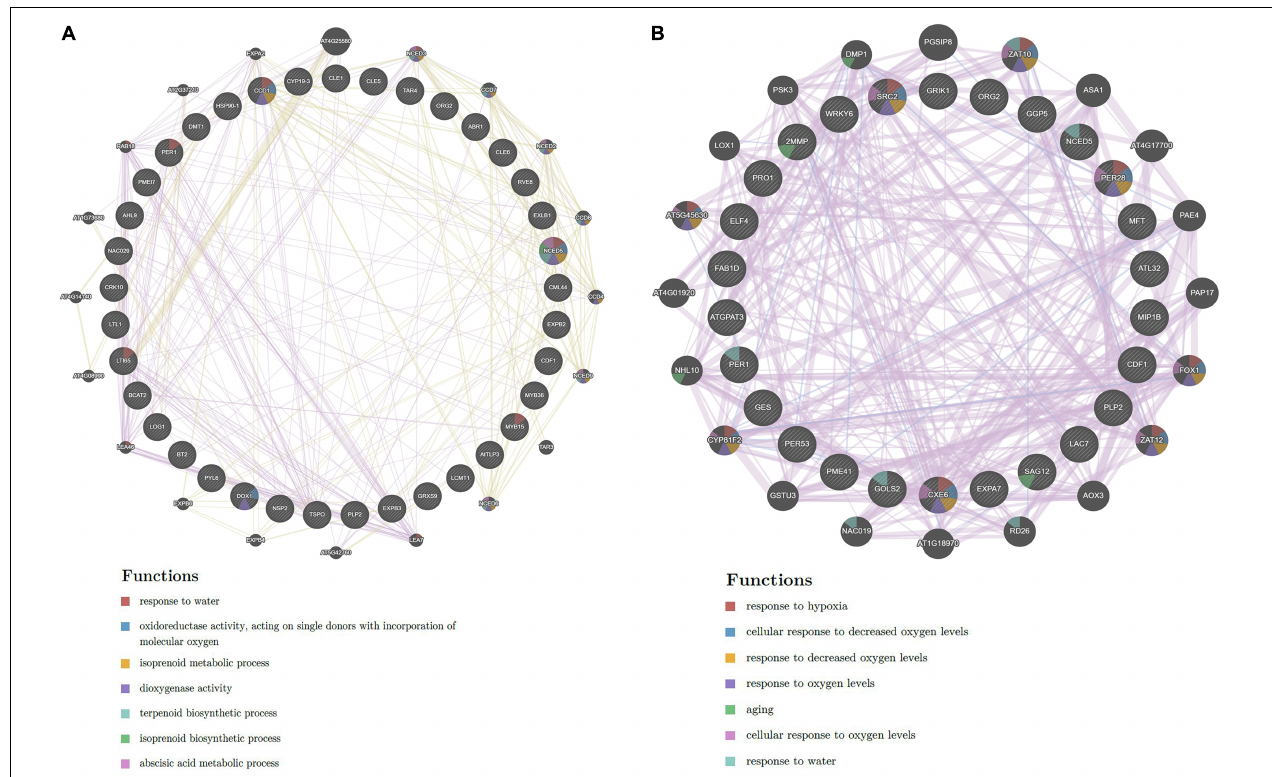
FIGURE 5 | Gene network of hub genes derived from GeneMANIA along with functional enrichment in (A) drought and (B) salt stress conditions.